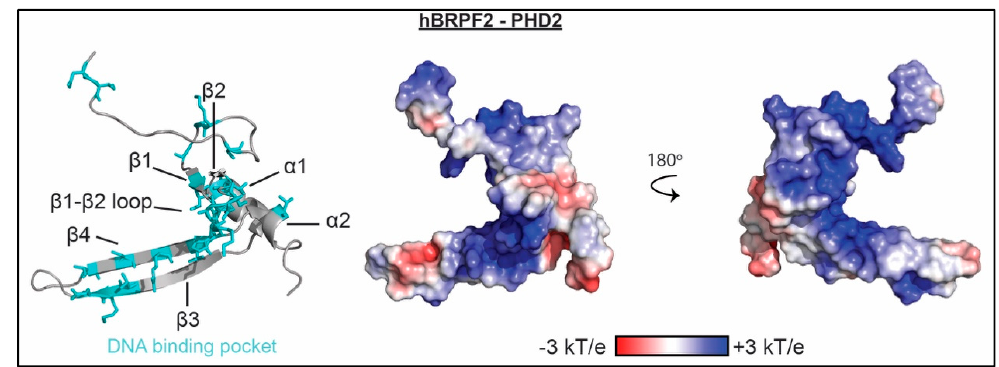
Figure 3. The molecular mechanism of PHD association with nucleic acid. Residues determined to be important for binding nucleic acid as mapped by NMR spectroscopy and/or mutagenesis are shown as cyan sticks on a ribbon representation of the BRPF2 PHD2 structure (PDBID 2LQ6). Corresponding representation of the electrostatic surface (determined using the APBS plug-in in pymol) is shown in two orientations.